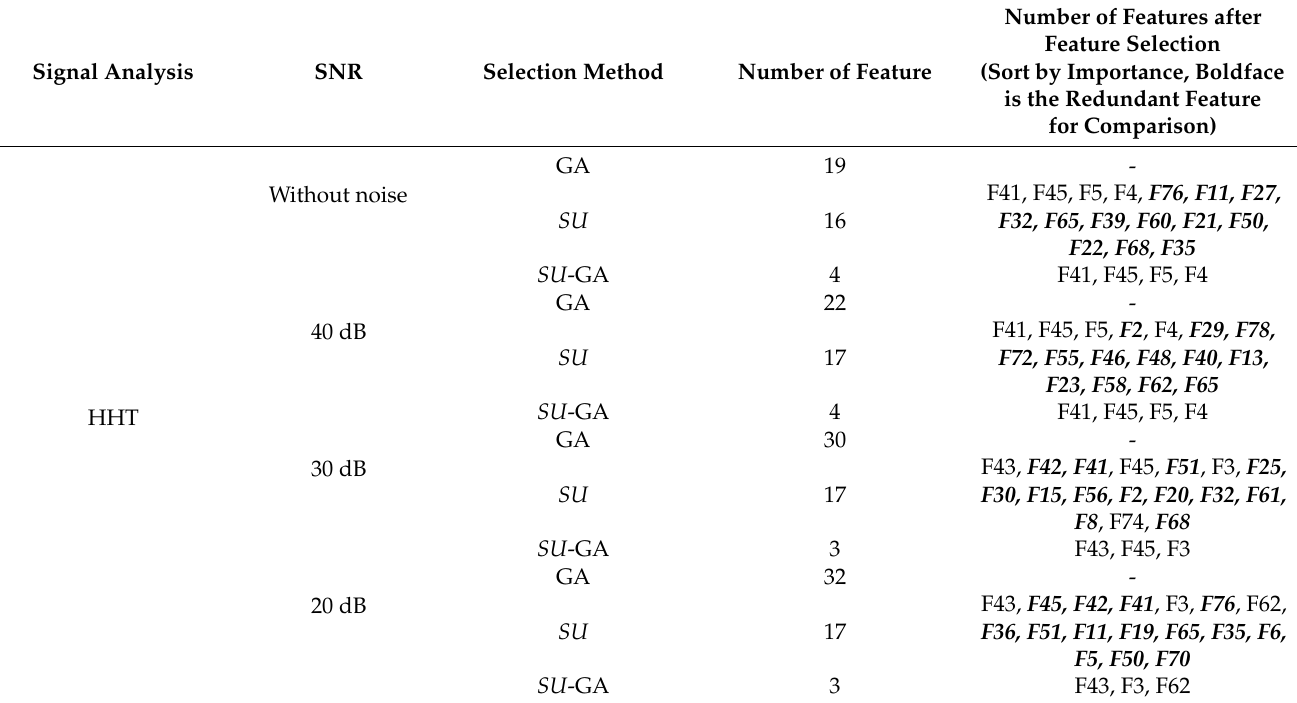
Table 4. Importance and quantity of features after feature selection.